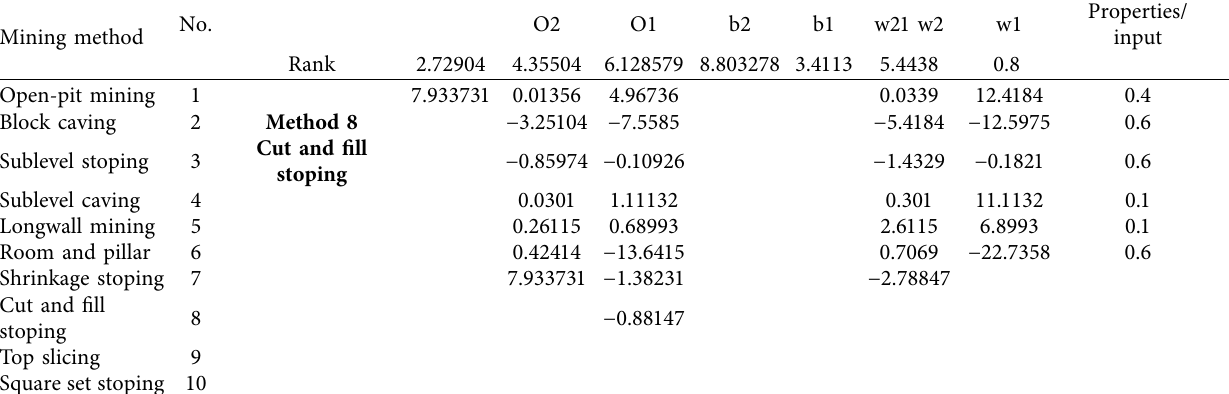
Table 7: Results of using CFBPNN for MMS with the given parameters.